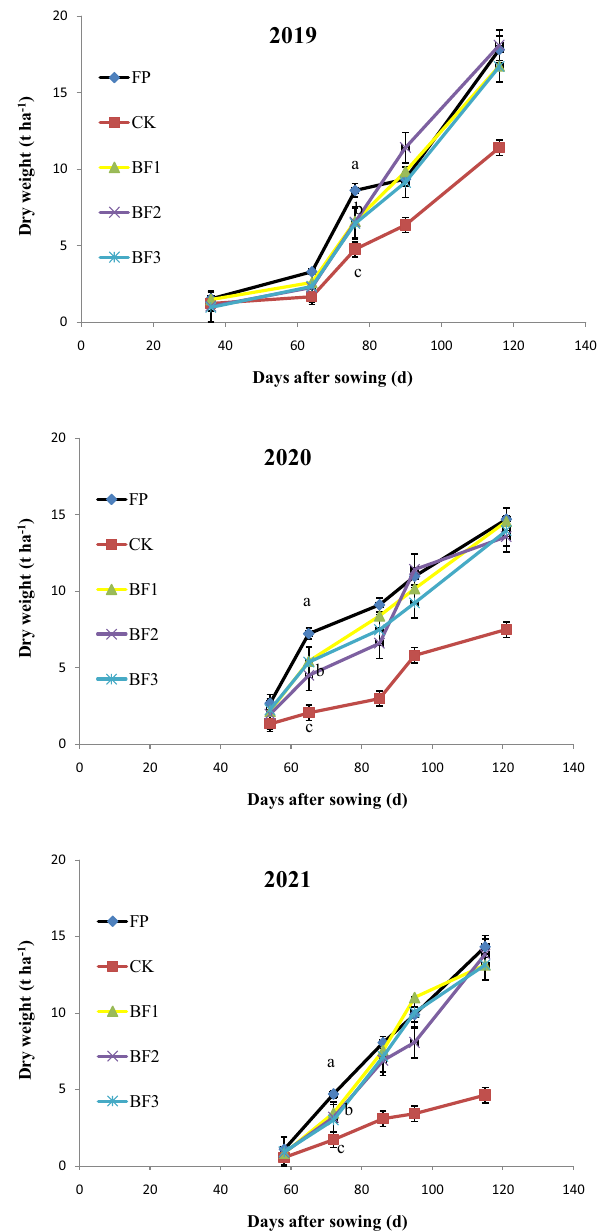
Figure 3. Dry matter accumulation of aboveground parts for different fertilization treatments in ( a ) 2019, ( b ) 2020 and ( c ) 2021. The data are the means and standard errors of three independent measurements. Vertical bars represent ± standard error of the mean (n = 3) where these exceed the size of the